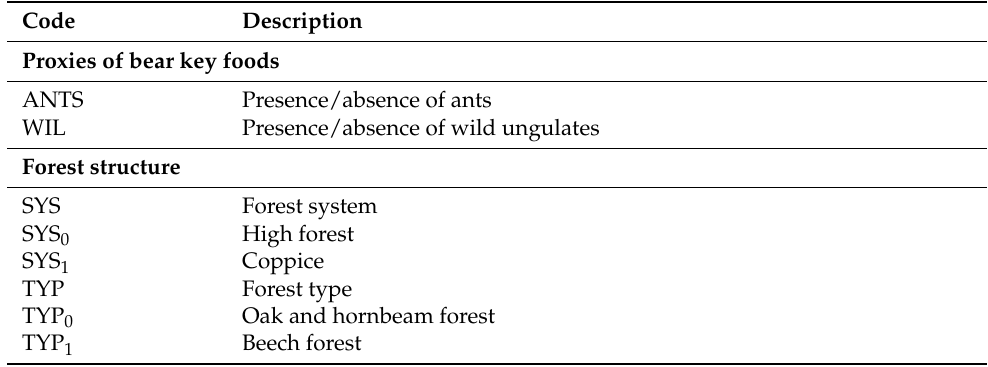
Table 3. List of categorical variables used to predict proxies of key foods for Apennine brown bears.